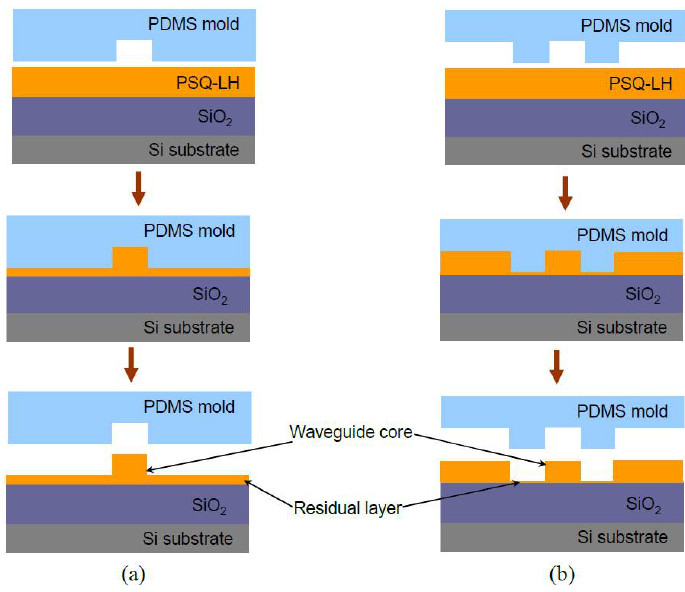
Figure 6. The schematic process of ( a ) the conventional imprinting technique and ( b ) the selective imprinting technique [36].